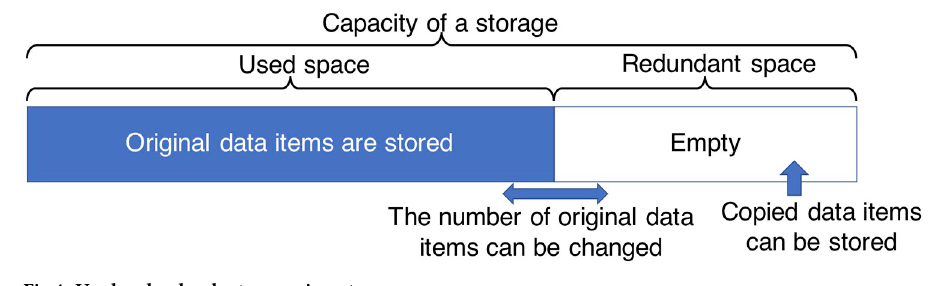
Fig 4. Used and redundant spaces in a